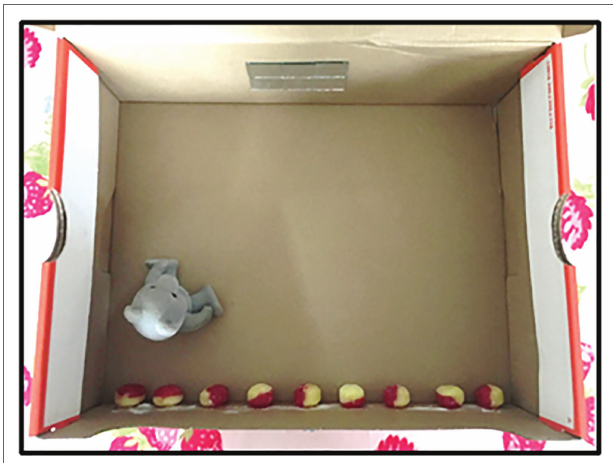
FIGURE 2 | The box was used to illustrate the task. This photo shows a teddy bear, but male and female dolls were also used to illustrate the ROMP